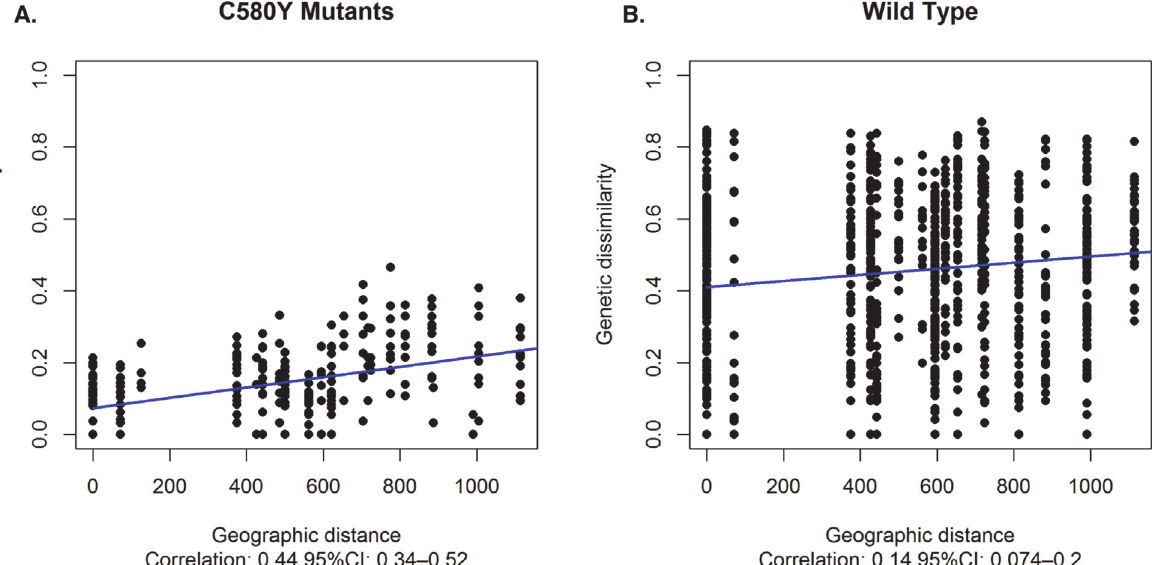
Fig 5. Association between genetic dissimilarity and geographic distance. (A) Genetic dissimilarity and geographic distance between pairs of C580Y mutants (A) and wild type parasites (B). Genetic dissimilarity of flanking microsatellites for C580Y is highly associated with geographic distance (Pearson's correlation coefficient: 0.44, 95% CI:0.34 – 0.52). Average genetic dissimilarity is lower between C580Y and wild type parasites (t-test p-value < 0.001).